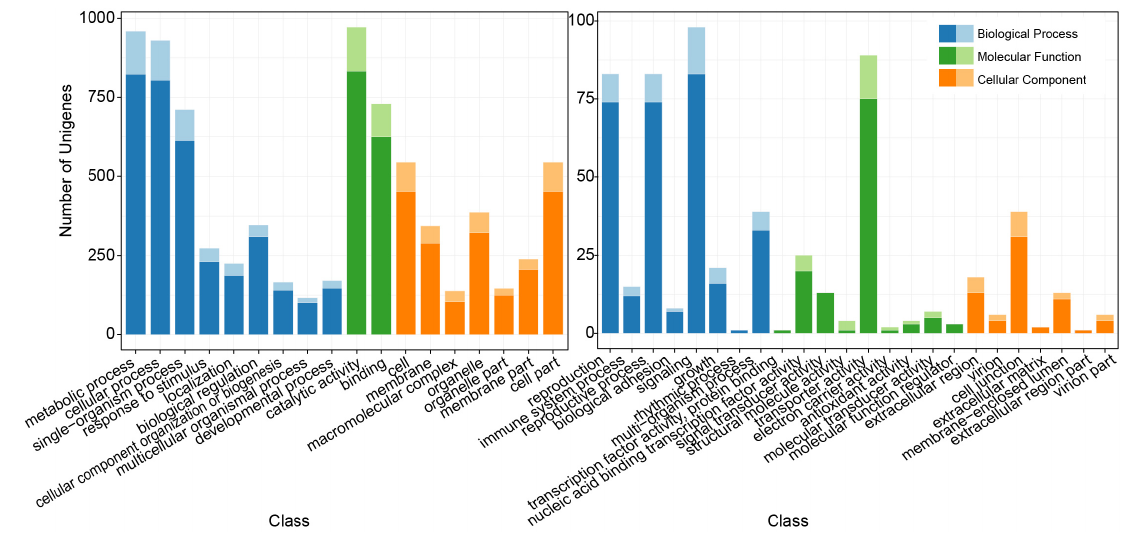
Figure 2. Gene Ontology (GO) analysis of unigenes containing SSRs. The lighter color of each bar represents the number of unigenes without matching coding sequences.